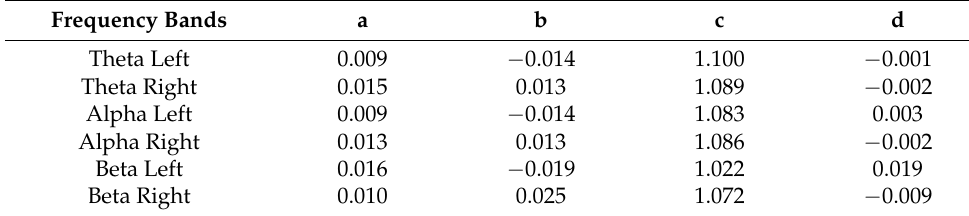
Table 1. Fit parameters as defined by Equation